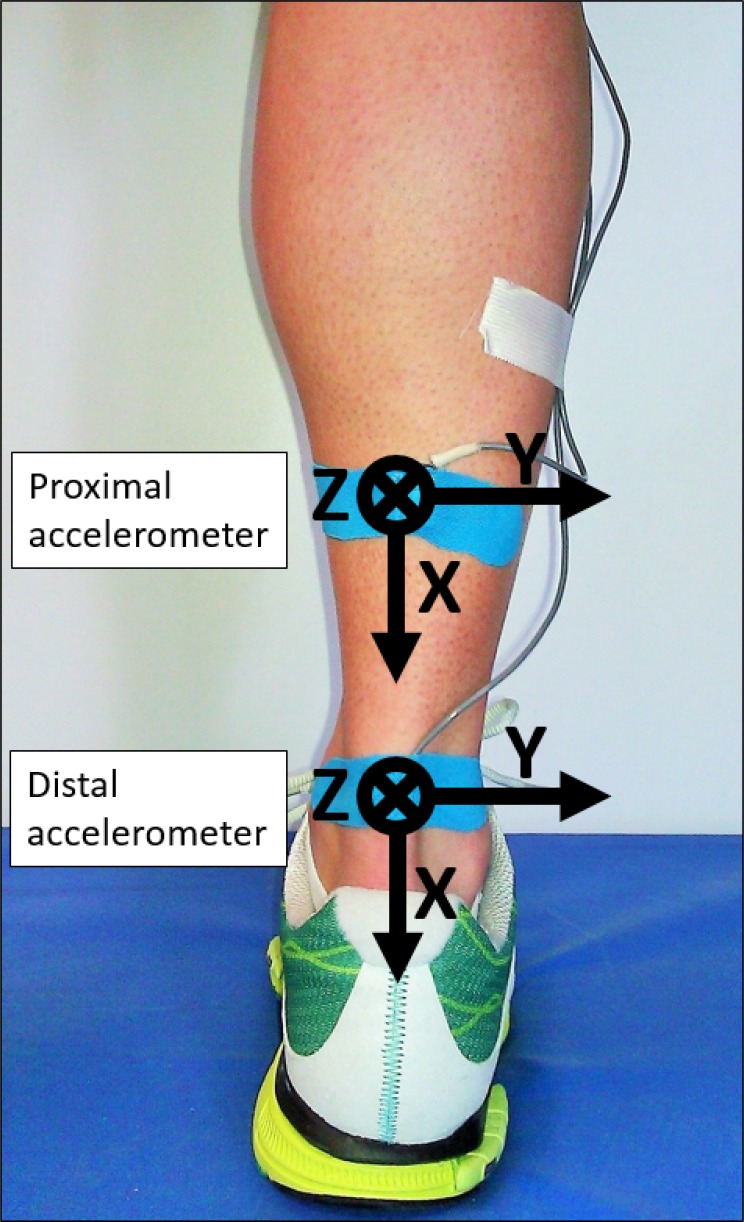
Placement of accelerometers.Both sensors were attached to the skin overlaying the Achilles tendon. The proximal accelerometer was located at 36% of tibial length while the distal accelerometer was affixed at 26% of tibial length.